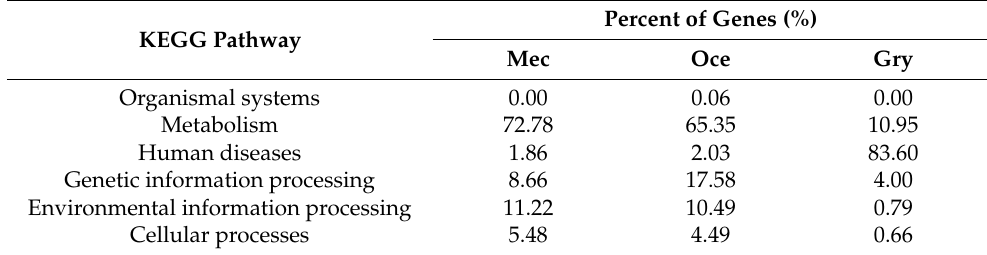
Table 3. The percent of gut microbiota was assigned to biological functions. KEGG